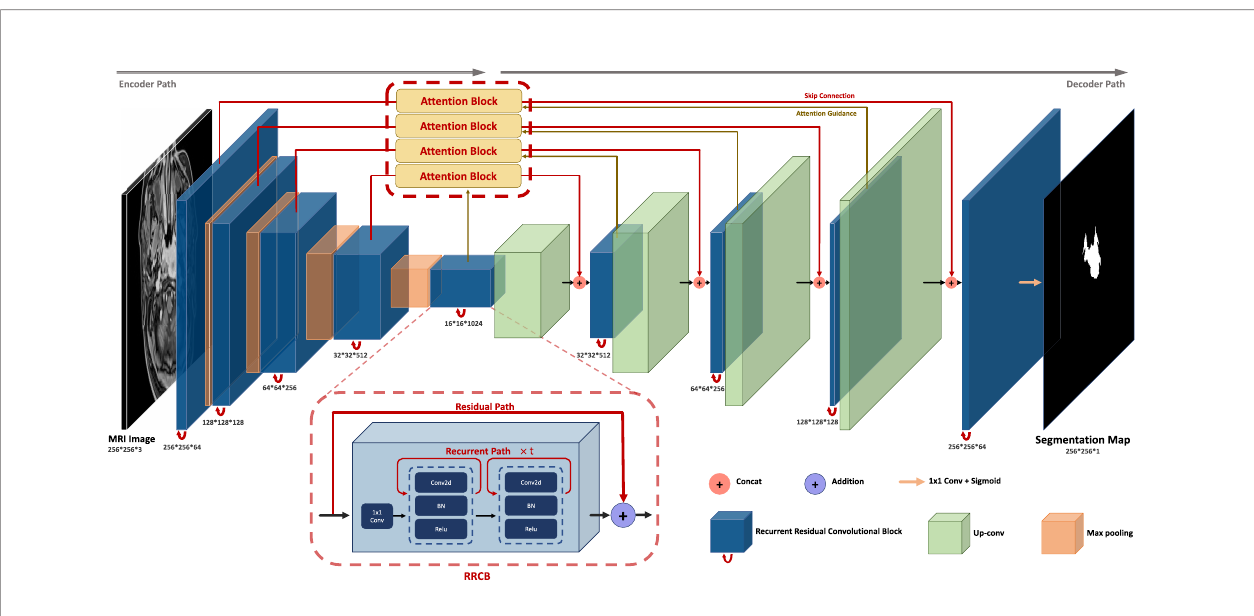
FIGURE 2 | The architecture of AttR2U-Net: The encoder in AttR2U-Net consists of fi ve Recurrent Residual Convolutional Blocks (RRCB). Each RRCB consists of a 1×1 convolution and two Recurrent Convolutional Layers, which loop Conv2d+BN+ReLU t times. Our model adds the input and output of each RRCN to achieve the residual connection. After each RRCB layer, our model sets a 2 × 2 max pooling layer to reduce the scale of the image by half. The decoder is symmetrically composed of four RRCBs, which are respectively connected with the fi rst, second, third, and fourth encoding layer through the attention mechanism. The attention map is fed to the RRCB after concatenating with the upsampling output. After each RRCB, our model places an Up-Conv layer, including an upsampling layer and a Conv2d+BN+ReLU operation. Then output the segmentation result after a 1 × 1 convolution and a sigmoid